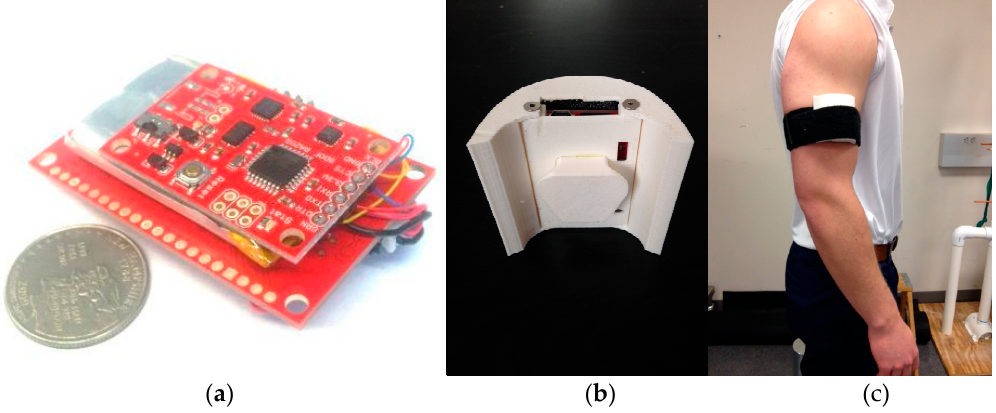
Figure 1. ( a ) Prototype IMU logger using off the shelf parts consisting of an IMU board on top, a data logger and power management board on bottom (facing away), and a lithium ion polymer battery between the two boards. Coin is a USA quarter; ( b ) The hardware was protected using a 3D-printed enclosure and ( c ) attached to each subject’s dominant arm as shown.